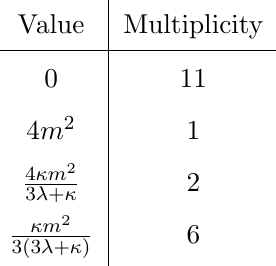
Table 10 . Scalar mass eigenstates for the SSB pattern SU(3) ! (cid:1)(27) using a 10 of